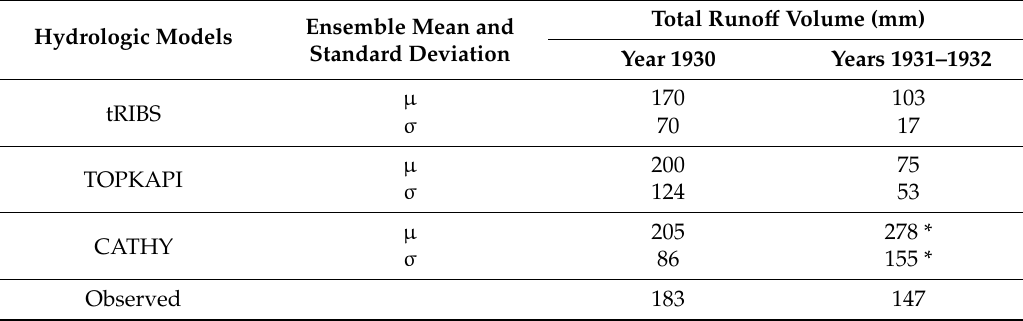
Table 5. Total runo ff volume (mm) computed (as ensemble mean and standard deviation across the 50 members for the three hydrologic models) and observed for the years 1930 (calibration period for tRIBS) and 1931–1932 (validation period for tRIBS). (*) Values obtained with the soil crusting assumption.